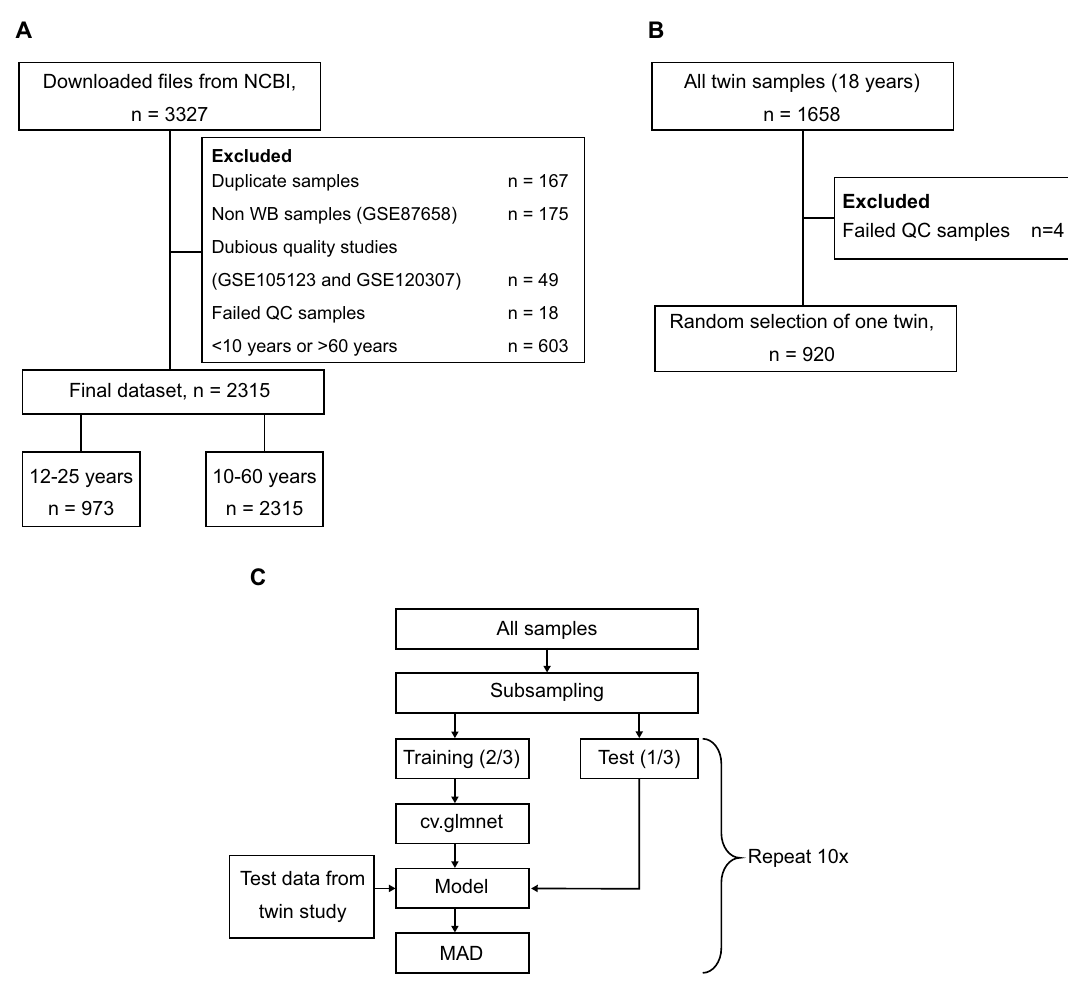
Figure 1. Sample retrieval and filtering. ( A ) Selection and quality control of the training data. ( B ) Selection and quality control of the independent test dataset. ( C ) The performance evaluation procedure. Using the training data, we selected 2/3 of the samples to fit an age prediction model using elastic net and the cross validation method. The remaining 1/3 of the samples were used to test the data, and the test dataset was also tested using the generated model. As a measure of prediction performance we used the median absolute deviation (MAD) in both